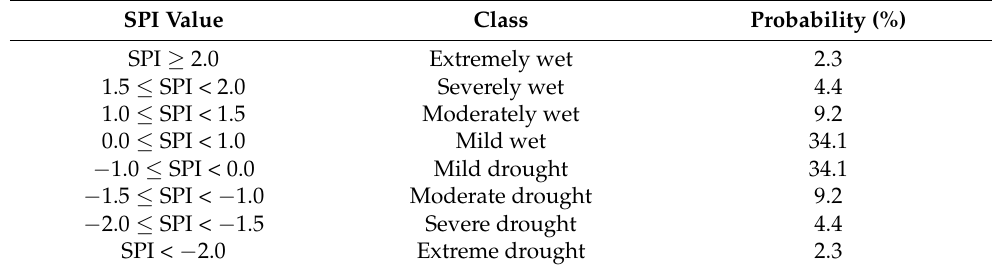
Table 1. Climate classification according to the standardized precipitation index (SPI) values.